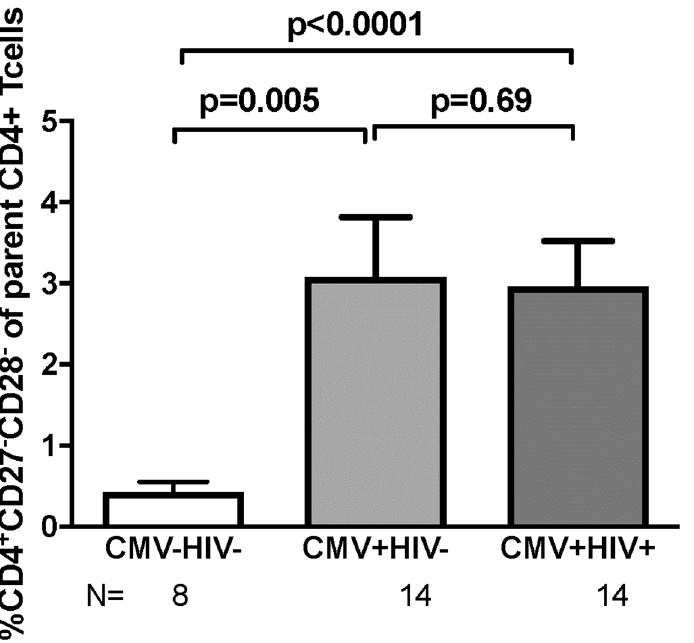
Fig 1. Frequency of CD4+CD27-CD28- T cells in peripheral blood of CMV-seronegative and CMV- seropositive with or without HIV co-infection. Data were derived from 36 donors. Bars indicatemeans and standarderrors. N indicatesthe numberof subjects in each group. P values were calculatedby unpaired Student’s t test using log-transformed values. blood parent population. Fig 2C shows that CD4+CD27-CD28- peripheral blood T cells of CMV-neg individuals also expressed higher levels of TGF β , GrB, IL-35 and CD39 and lower levels of CD127 compared with their parent total CD4+ T cells. In contrast to CMV-pos, the CMV-neg peripheral blood CD4+CD27-CD28- T cells had lower FOXP3 expression com- pared with the parent total CD4+ T cell population.